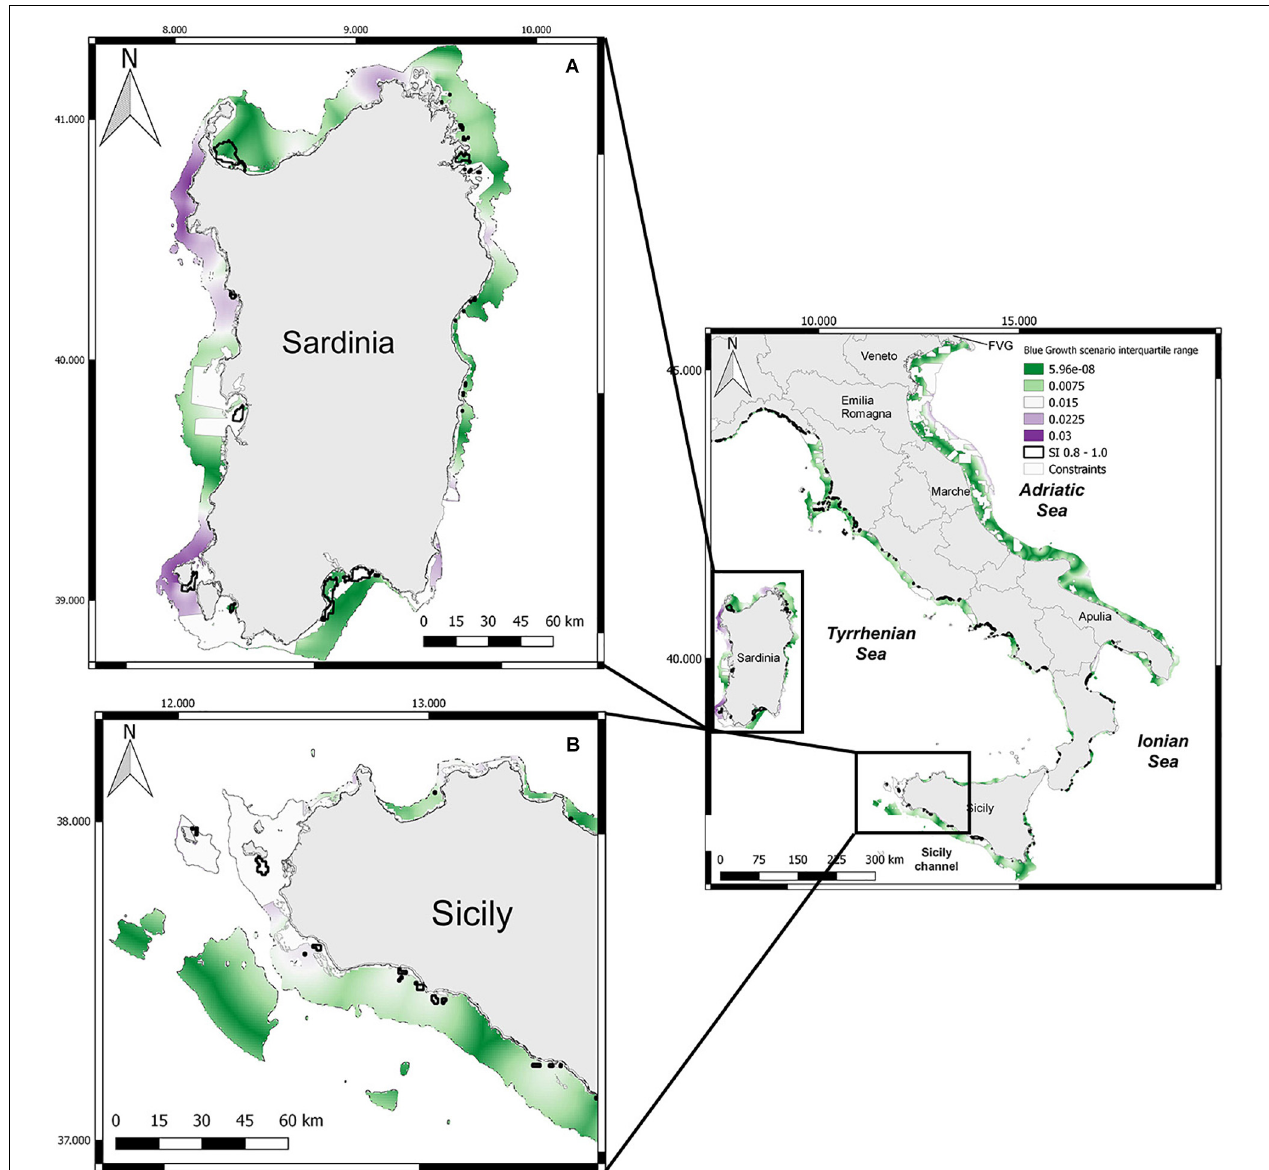
FIGURE 5 | Blue Growth uncertainty considering the area with a persistent high SI and the current sea uses: (A) Sardinia. (B) East